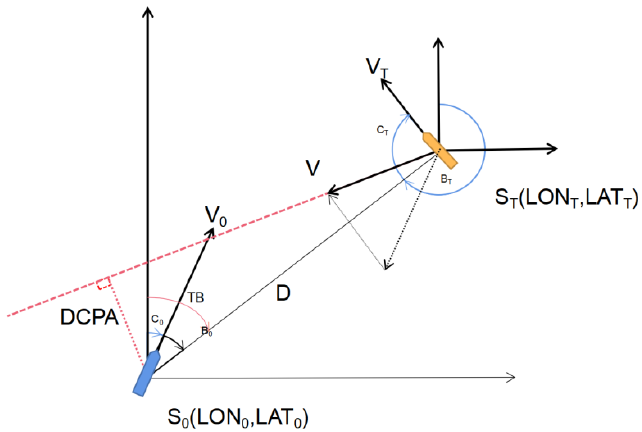
Figure 6. The relationship between ship encounter geometric